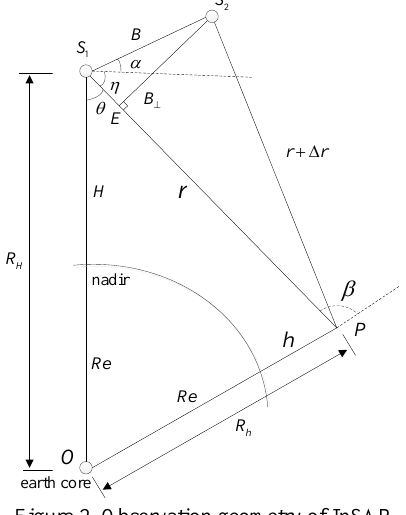
Figure 2. Observation geometry of InSAR Figure 2 shows the observation geometry of the InSAR measurement. According to the cosine law, the